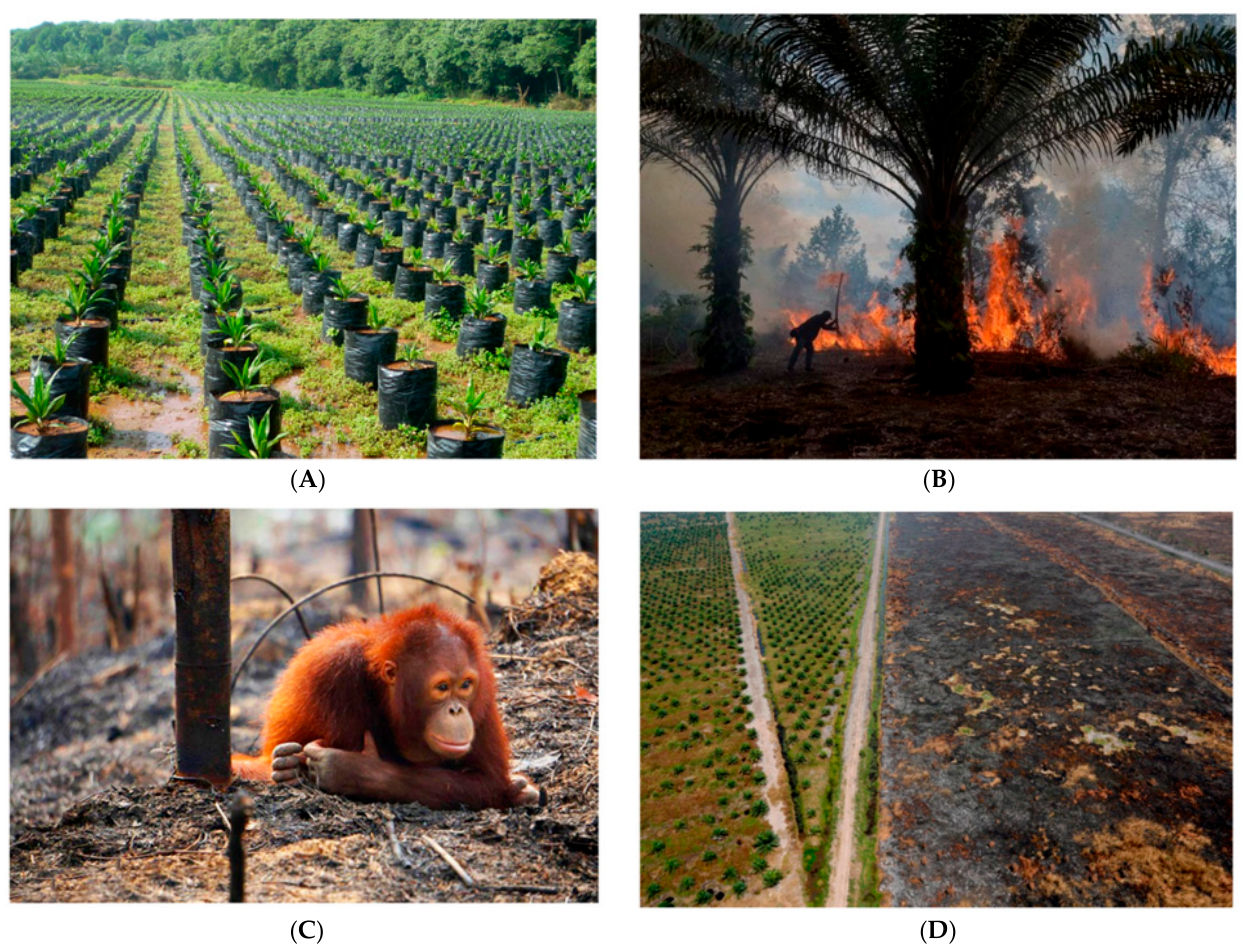
Figure 1. Monocrop plantations, owned and operated by transnational corporations, cause local climates to warm and threaten tropical forest integrity and biodiversity. These externalities of the palm oil production process comprise a major threat to tropical forest ecosystems worldwide. Externalities as ecosystem threats are represented by: ( A ) monoproduction and industrial monocropping (photo credit: GRAIN); ( B ) large-scale wildfires as a result of industrial plantations (photo credit: Wahyudi, Agence France-Presse); ( C ) displacement by logging or fires, resource partitioning, and character displacement (photo credit: Paulina L. Ela, Borneo Orangutan Survival Foundation); and ( D ) edge effects and habitat fragmentation (photo credit: Willy Kurniawan, Reuters).